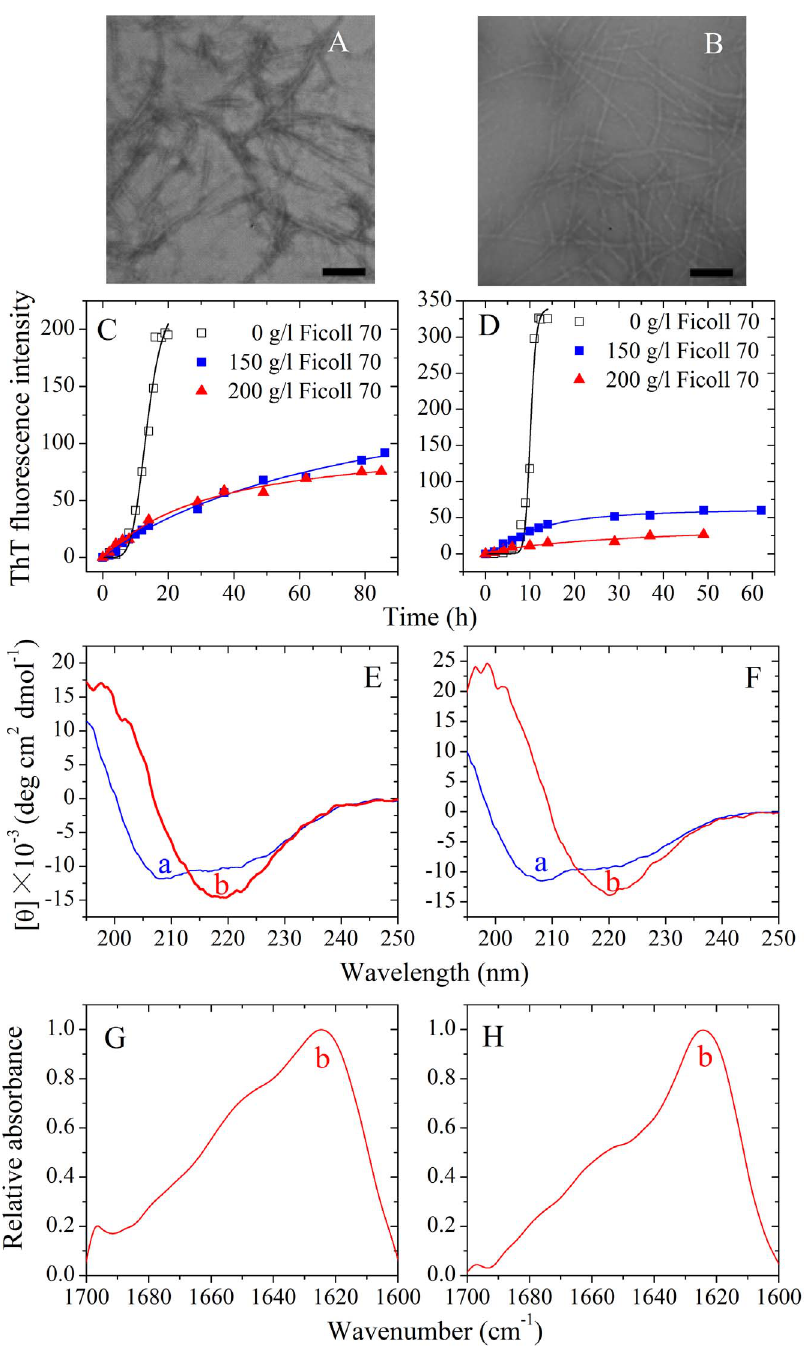
Figure 7. Amyloid formation of human PrP-H2H3 and rabbit PrP-H2H3. Transmission electron micrographs of human PrP-H2H3 (A) and rabbit PrP-H2H3 (B) were made after incubation under different conditions. PrP-H2H3 samples were incubated in the absence of a crowding agent for 14 h (A) and 10 h (B), respectively. Fibril formation of human PrP-H2H3 (C) and rabbit PrP-H2H3 (D) in the absence and in the presence of Ficoll 70, monitored by ThT fluorescence. All experiments were repeated at least three times. The final concentrations of all prion proteins were 10 m M. The crowding agent concentrations were 0 (open square), 150 g/l (solid square), and 200 g/l (solid triangle), respectively. The empirical Hill equation was fitted to the data and the solid lines represented the best fit. Secondary structural changes of human PrP-H2H3 (E and G) and rabbit PrP-H2H3 (F and H) isoforms monitored by far-UV CD and FTIR, respectively. Curve a: native human/rabbit PrP-H2H3. Curve b: amyloid fibrils produced from human PrP-H2H3 and rabbit PrP-H2H3 incubated for 20 h in the absence of a crowding agent.